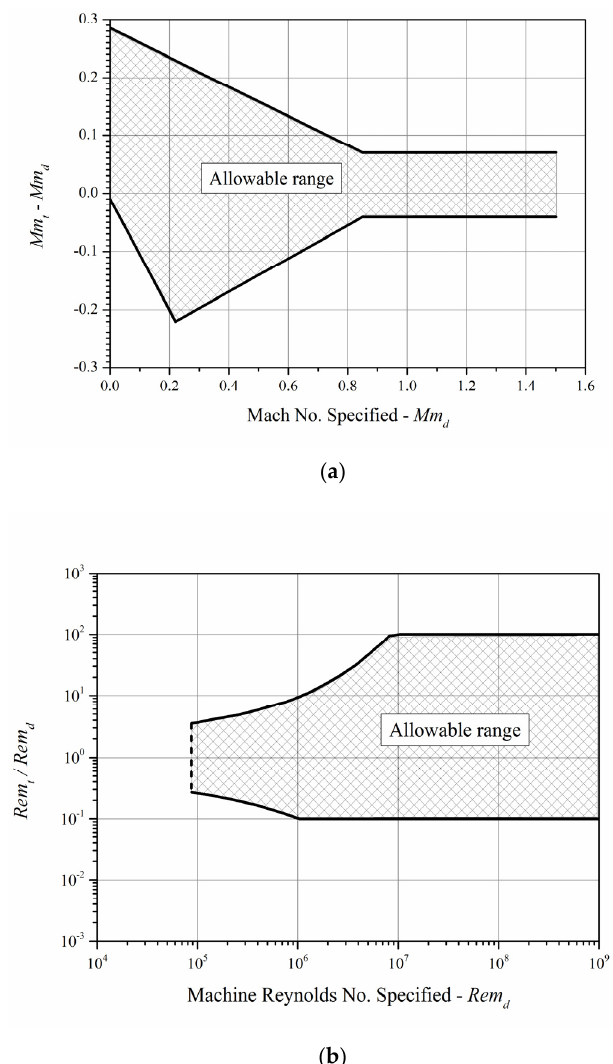
Figure 2. Allowable range diagram: ( a ) machine Mach number and ( b ) machine Reynolds number adapted from [15], with permission from 2017 American Society of Mechanical Engineers, 2017.